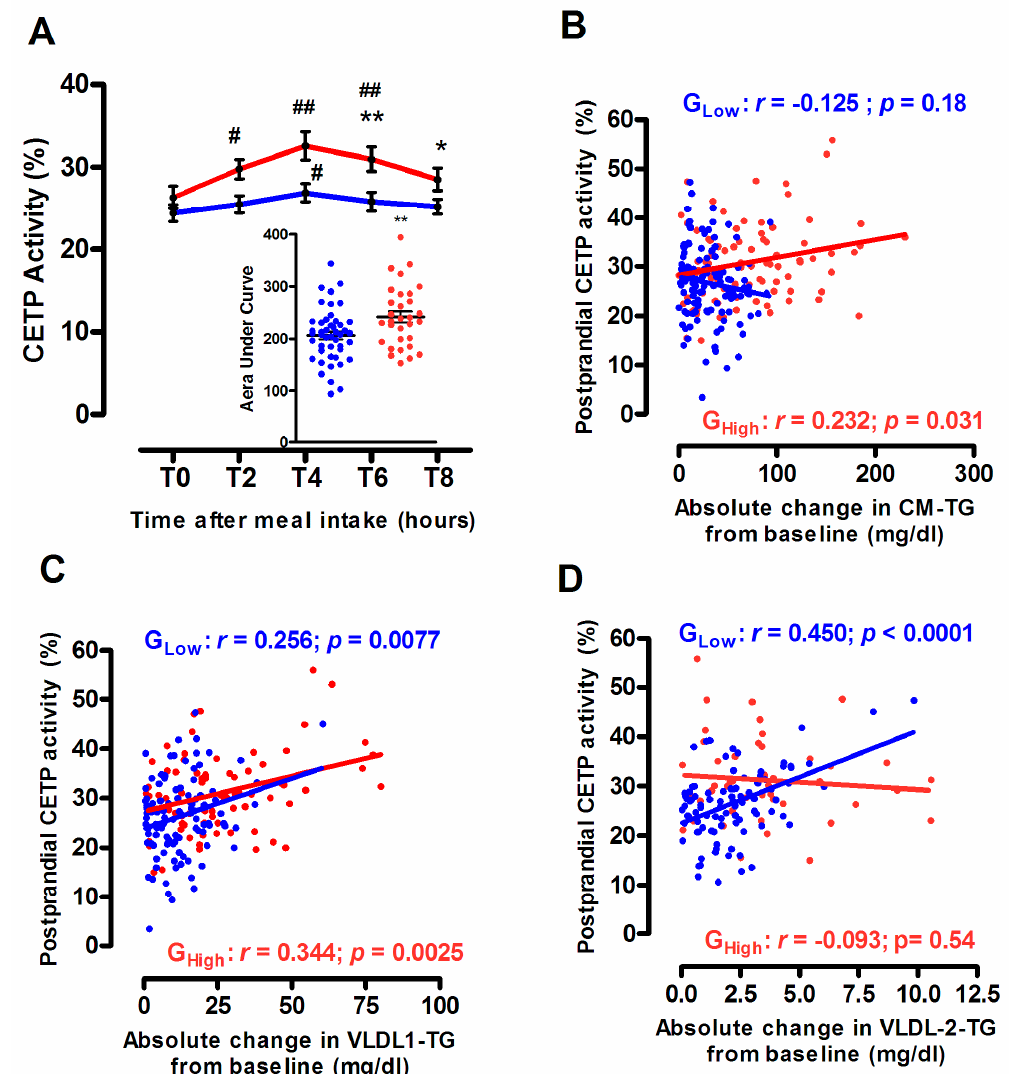
Figure 5. Postprandial time course of endogenous cholesteryl ester transfer (CETP) activity in subjects from G Low (blue curve) and G High (red curve). Insert represents the area under the curve (AUC) in subjects from G Low (blue dots) and G High (red dots) ( A ). Relationship between absolute changes in postprandial CM-TG ( B ), large VLDL1-TG ( C ), small VLDL2-TG ( D ) levels determined at 2 h, 4 h and 6 h after the meal intake and CETP activity in subjects from G Low (blue line) and G High (red line). Values are mean ± SEM. * p < 0.05 and ** p < 0.01 versus G Low. . # p <0 .05 and ## p <0.001 versus before the meal intake.